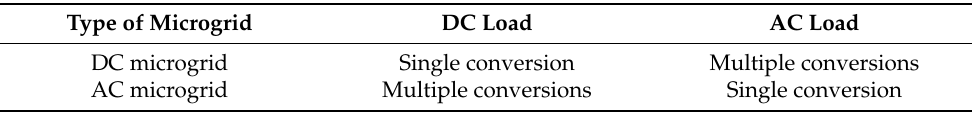
Table 1. Comparison of AC and DC microgrid conversion